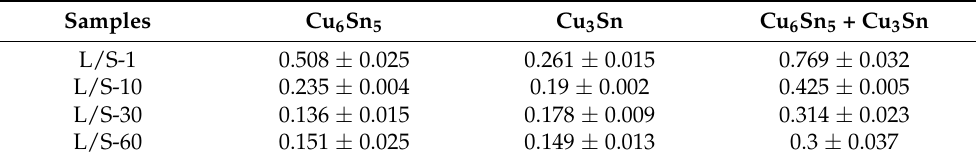
Figure 5. Thicknesses of the IMCs as a function of the square root of reaction time for various liquid/solid joints: ( a ) Cu 6 Sn 5 , ( b ) Cu 3 Sn, and ( c ) Cu 6 Sn 5 + Cu 3 Sn. Table 2. Growth rate constants ( k ) of Cu 6 Sn 5 , Cu 3 Sn, and Cu 6 Sn 5 + Cu 3 Sn for thermal aging (solid/solid) reactions at 200 °C (unit: µm/h 0.5 ). Samples